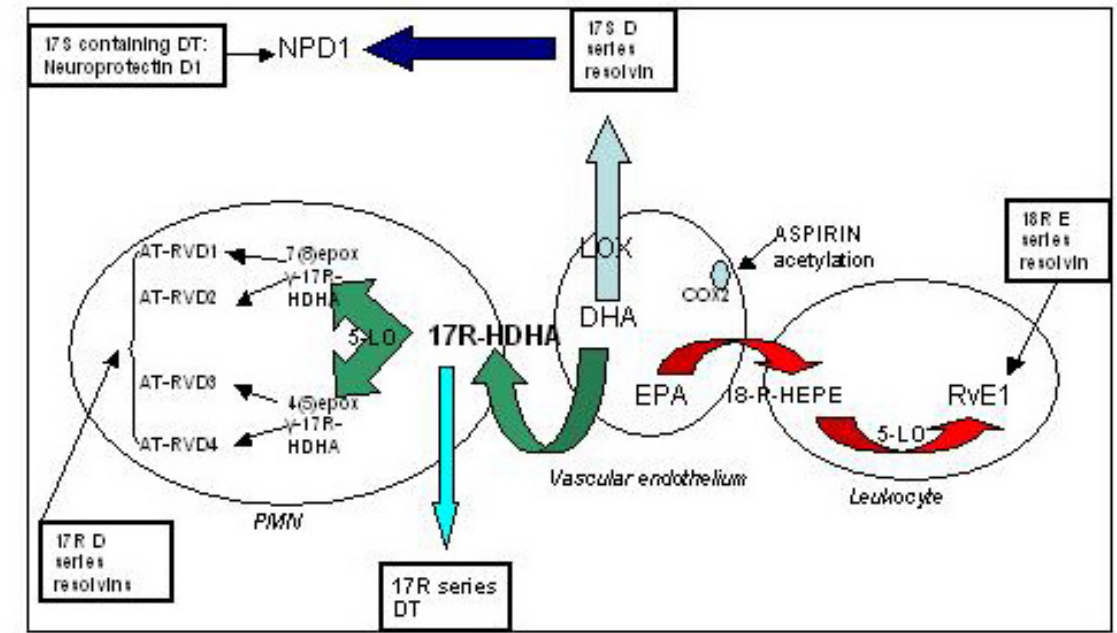
FIGURE 3. DHA is a source for 17R D series resolvins and EPA a source for 18R E series resolvin after COX-2 acetylation by aspirin. DHA also gives rise to 17R and 17S docosatrienes in the absence of aspirin. The latter can also induce neuroprotectin formation ie: